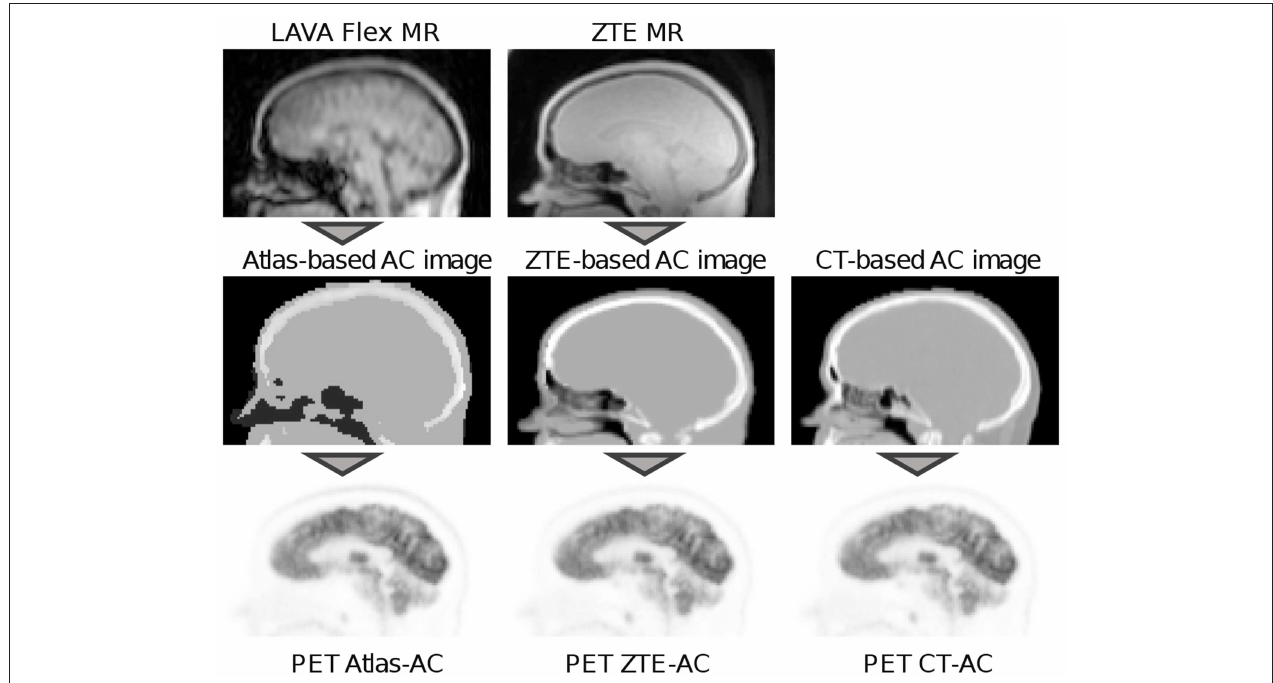
FIGURE 1 | Workflow of the PET reconstructions used in this study. In the reconstruction of PET AtlasAC an atlas-based attenuation image that was derived from a LAVA flex MR image was used for attenuation correction (left column). The atlas-based attenuation image was generated with the vendor-provided software version MP24. In the reconstruction of PET ZTEAC attenuation correction was performed using a ZTE-based attenuation image that was derived from a ZTE MR image (middle column). The ZTE MR post-processing was done with a research tool provided by the vendor. For PET CTAC a co-registered CT-based attenuation image from a PET/CT acquisition of the same day was used. In all attenuation images, templates for the bed and the head coil were